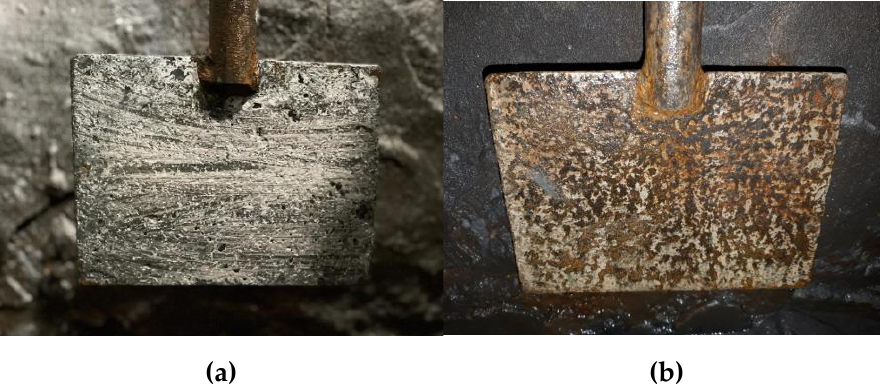
Figure 15. View of the reference plate installed inside the classifier tank: ( a ) plate with cathodic protection, ( b ) plate without cathodic protection.